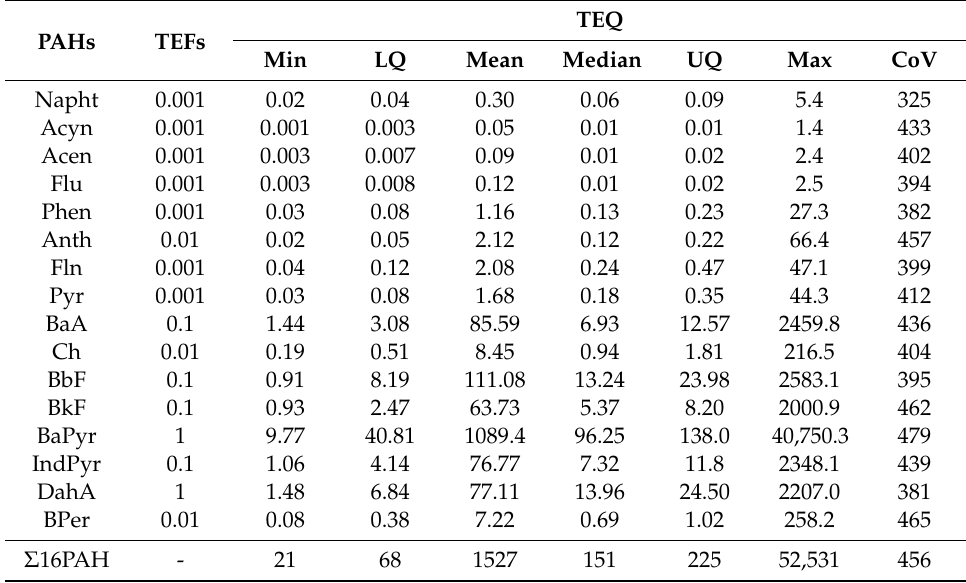
Table 5. Descriptive statistics of toxic equivalent concentration (TEQ, µ g kg − 1 ) for individual PAH compounds and the toxic equivalent factors (TEFs) used for TEQ